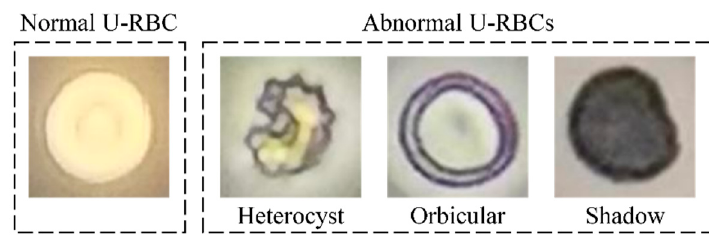
Figure 2. The typical shapes of U-RBCs.